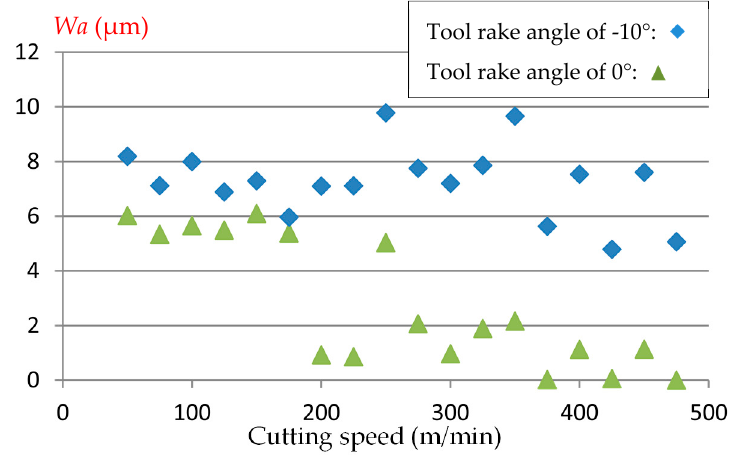
Figure 4. Effect of the tool rake angle on the arithmetic mean deviation of the waviness profile W a (uncut chip thickness = 0.01 mm; width of cut = 1.5 mm; cutting speed = 50 to 500 m/min).